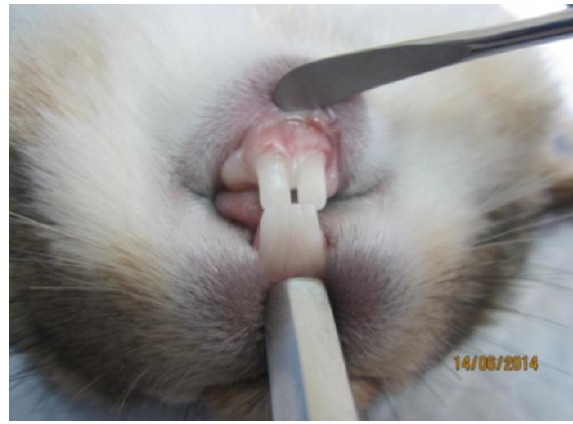
Figure 1. Permanent maxillary and mandibular incisor teeth of New Zealand